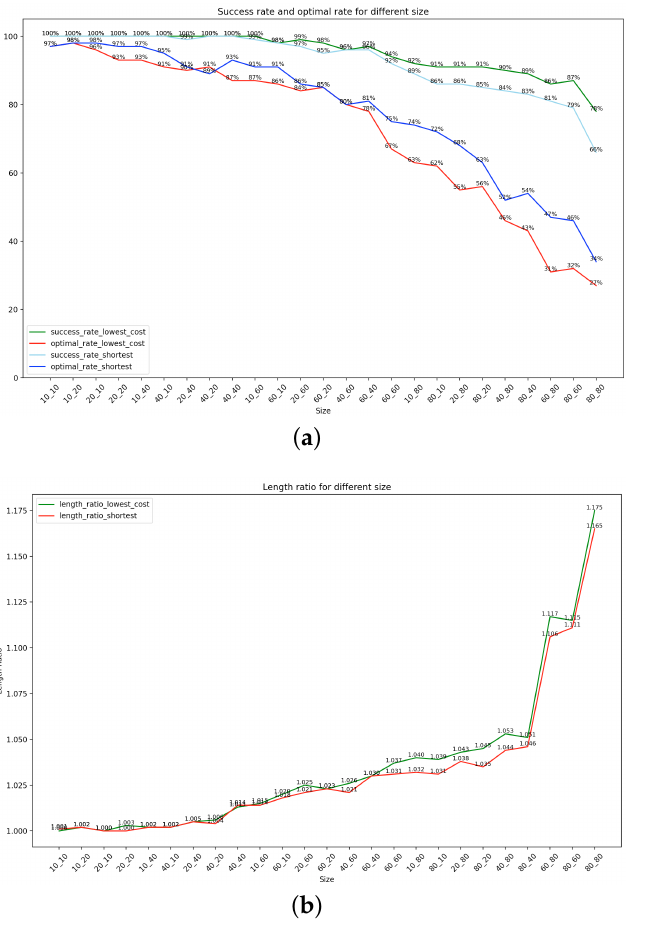
Figure 6. ( a ): Success rate and optimal rate of different sizes; ( b ): Length ratio of different